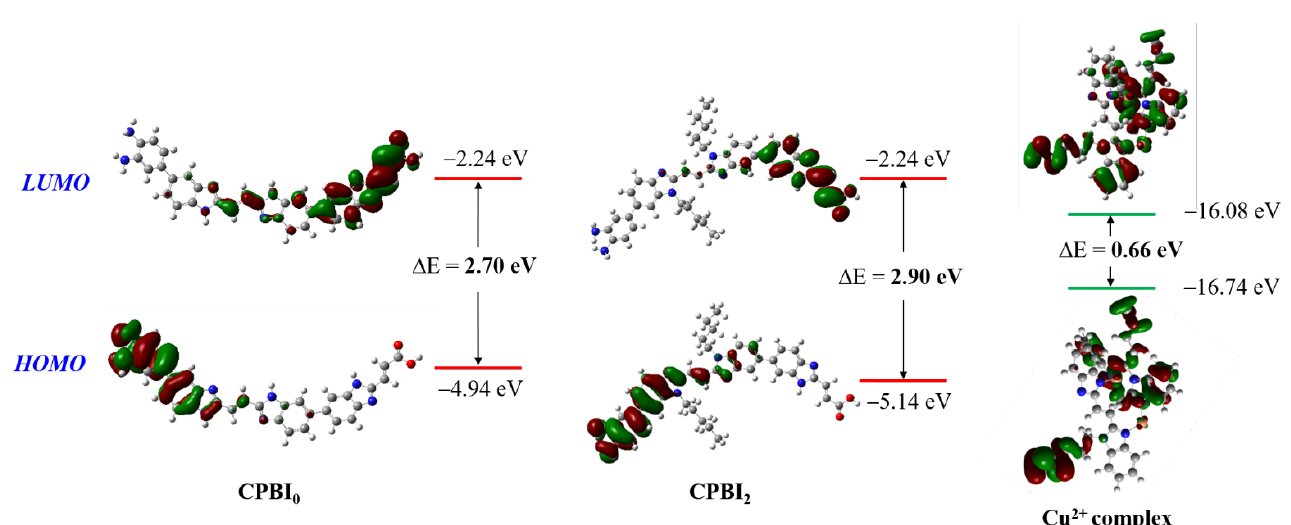
Figure 8. The optimized geometries of CPBI 2 , its Cu 2+ complex, and CPBI 0 (B3LYP/6-31G basis set CPBI 0 , CPBI 2 , and B3LYP/6-31G basis set for C, H, N; LanL2DZ for Cu 2+ in complex).